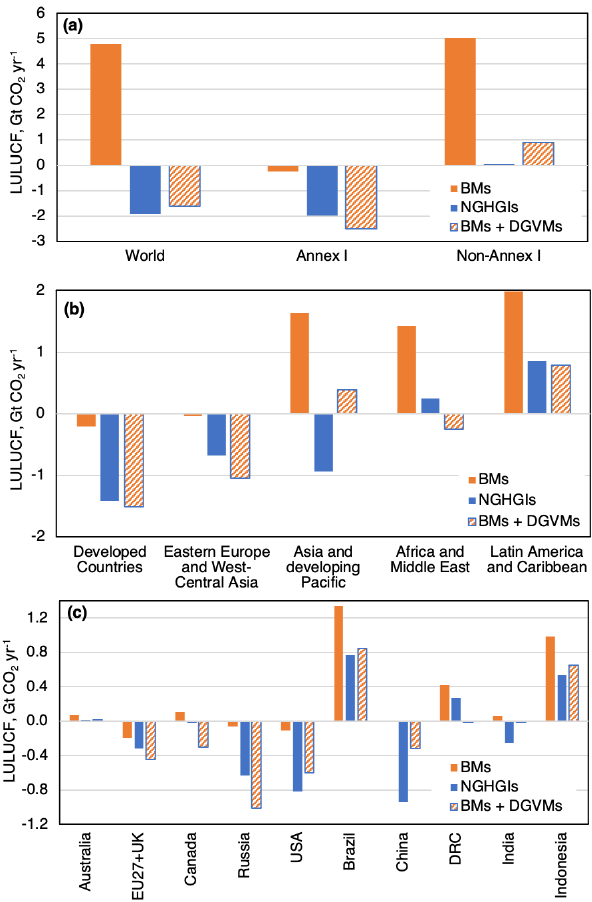
Figure 7. LULUCF CO 2 fluxes (average 2000–2020) from BMs, from the sum of BMs and DGVMs (in non-intact forest only) and from NGHGIs, for the world, Annex I countries (AI), and Non- Annex I countries (NAI, panel a ) and for five macro-regions (b) and for 10 large individual countries (c)